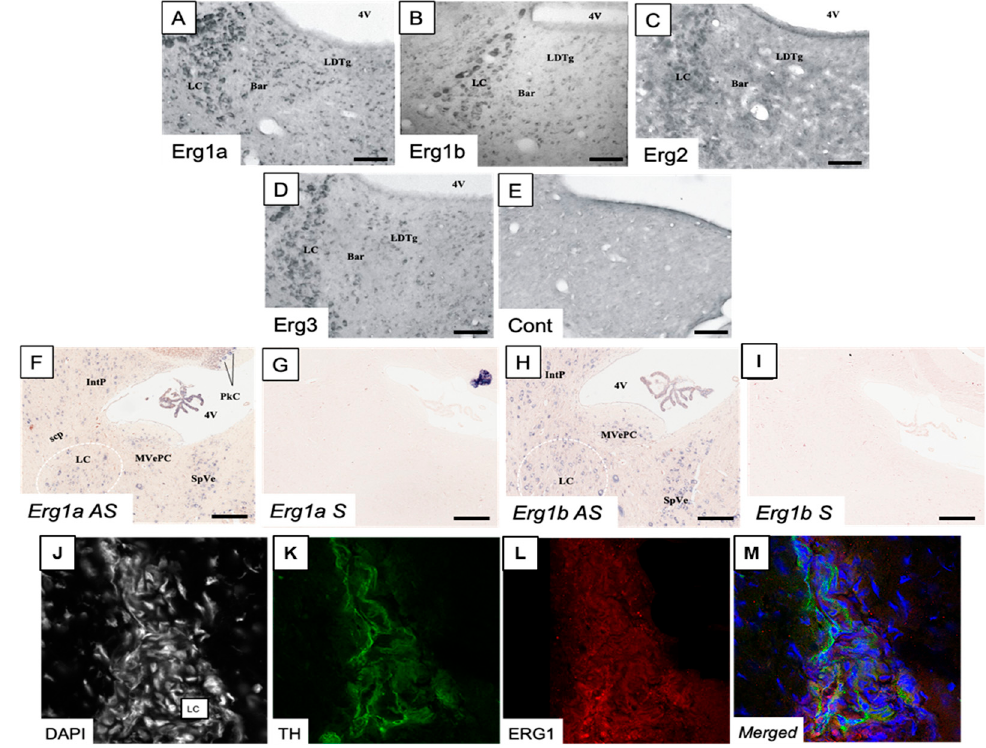
Figure 1. Expression of ERG1 channels in LC neurons. ( A – D ) Expression of Erg1a ( A ), Erg1b ( B ), Erg2 ( C ) and Erg3 ( D ) proteins in the LC and adjacent areas, as visualized through immunohistochemistry. ( E ) represents a stained section where the primary antibody was omitted. ( F – I ) Expression of Erg1a ( F ) and Erg1b ( H ) mRNAs in the LC and adjacent areas (sagittal sections), via non-radioactive in situ hybridization using anti-sense probes. Sections processed in parallel with sense probes ( G , I ) showed no signal. High magnification images of LC stained with the anti-TH ( K ) and anti-ERG1 ( L ) antibodies. Images of neurons stained with DAPI ( J ) and merged ( M ) are reported. Note that cells within the LC nucleus (indicated as LC) were heavily stained by the anti-TH specific antibody (green signal). Staining with anti-ERG1 antibody (red signal) was also present. Scale bars ( A – I ) = 100 μ m, ( J–M ) image size is 185 × 185 μ m. Abbreviations: 4V, 4th ventricle; Bar, Barrington’s nucleus; IntP, interposed cerebellar nucleus, posterior part; LC, Locus coeruleus; LDTg, laterodorsal tegmental nucleus; MVePC, medial vestibular nucleus, parvicellular part; PkC, Purkinje cells; SpVe, spinal vestibular nucleus.